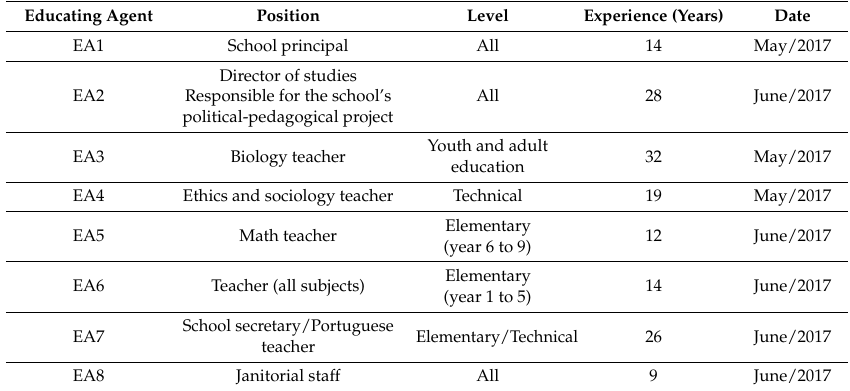
Table 1. Education agents interviewed in the Washington Luiz Municipal School. Source: Created by the authors.